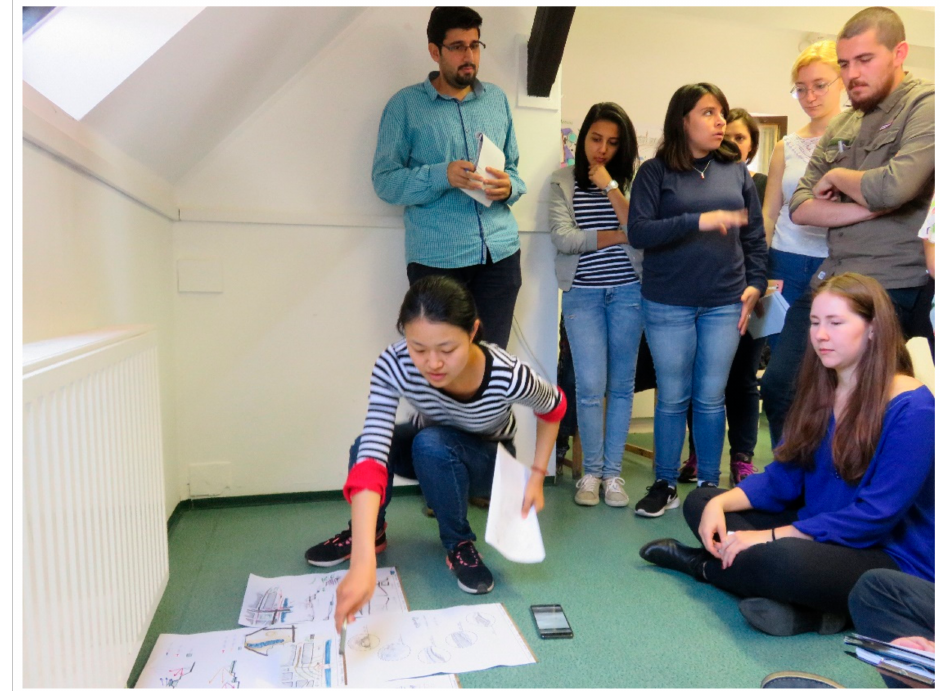
Figure 5. Group work and individual learning; presenting fieldwork in a Seminar on “Space, theory and practice in landscape architecture” for first year Master’s students at the Faculty of Landscape architecture and urbanism in Budapest. The work of each assignment is presented and discussed in the studio. Learning to present, seeing the work of other students discussing results with all participants and the grades afterwards define the learning effect of each individual